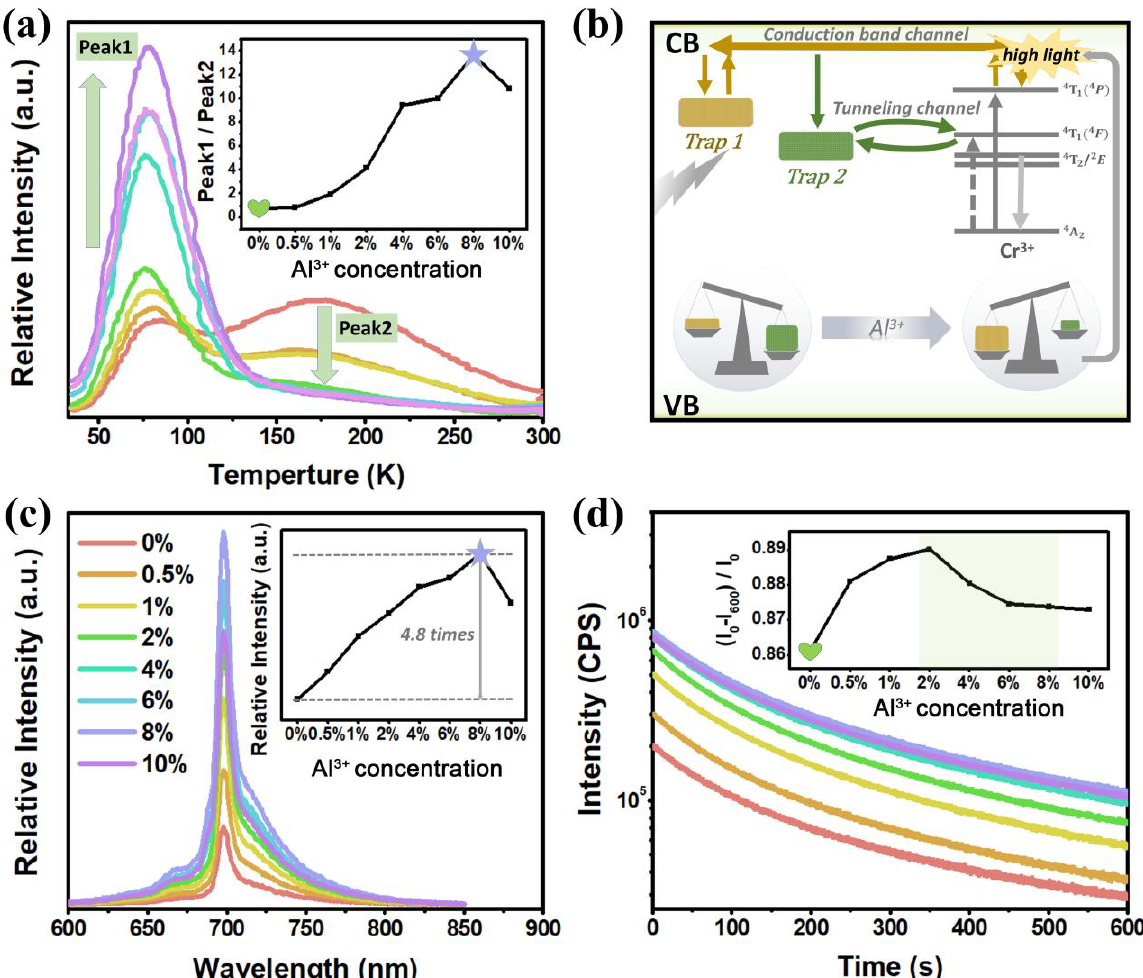
Figure 4. Properties of LPL. ( a ) TL spectra of Li 2 Zn 1-z Ge 3-z Al 2z O 8 : 0.4%Cr 3+ (z = 0–10%), inset: the proportional relationship between the TL intensity of shallow trap (peak 1) and deep trap (peak 2); ( b ) effect plot of CB channel and TN channel on PersL emission; ( c ) PersL spectra of Li 2 Zn 1-z Ge 3-z Al 2z O 8 : 0.4%Cr 3+ ; ( d ) PersL decay curve of Li 2 Zn 1-z Ge 3-z Al 2z O 8 : 0.4%Cr 3+ , inset: trend of decay rate of PersL at different z values.